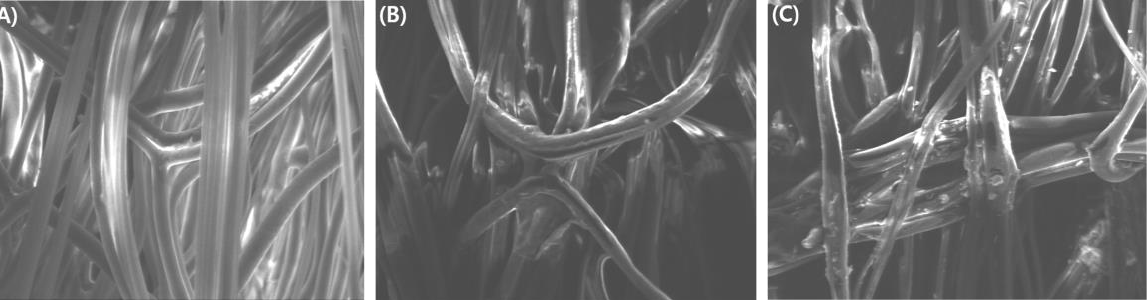
Figure 9. SEM image of each functional MNWF. ( A ): GMA MNWF, ( B ): 4-AMP MNWF, ( C ): 4-AMP- Cu MNWF. Each of MNWF’s dg is 170%.